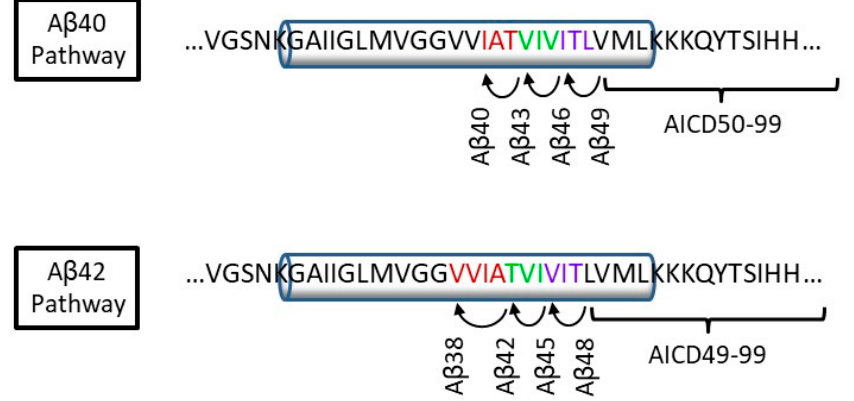
Figure 3. Processive proteolysis of APP substrate by γ -secretase. Initial endoproteolysis at the ε cleavage site of APP substrate C99 results in A β 48 or A β 49 and corresponding APP intracellular domain fragments AICD49-99 and AICD50-99. The carboxypeptidase activity of γ -secretase then trims the initial A β peptides along two pathways: A β 49 → A β 46 → A β 43 → A β 40 and A β 48 → A β 45 → A β 42 → A β 38. The generated A β 48 and A β 49 (counterparts of AICD49-99 and AICD50-99, respec- tively) were postulated to undergo tripeptide trimming along two pathways: A β 49 → A β 46 → A β 43 → A β 40 and A β 48 → A β 45 → A β 42 → A β 38 (this last cleavage step generating a tetrapeptide coproduct). Mass spectrometric analysis of the small peptide products